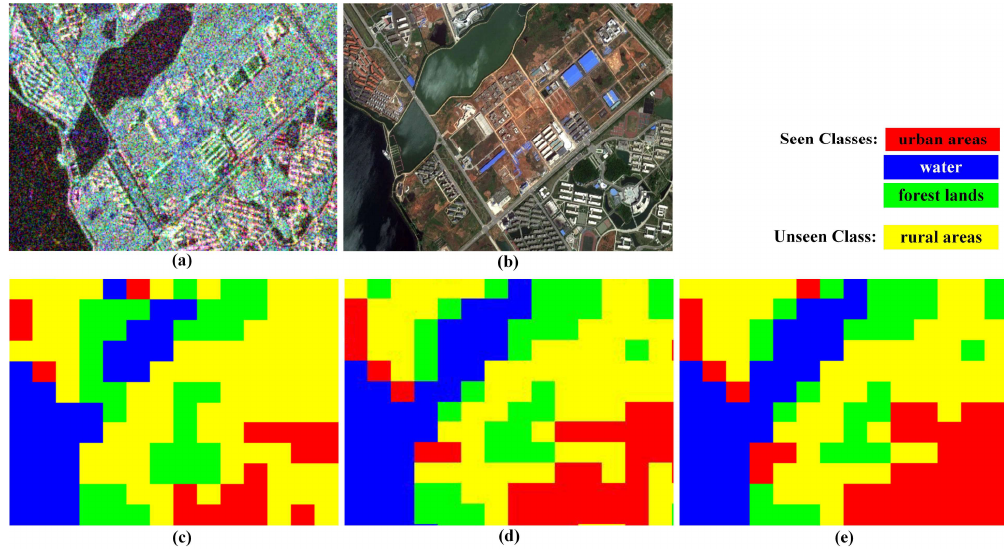
Figure 7. The ROI in Figure 6 and the GZSL classification results. ( a ) The Pauli image of ROI; ( b ) the corresponding Google Earth optical image of ROI; ( c ) the results with the Word2Vec attributes applied; ( d ) the results with the SUN attributes applied; and ( e ) the results with the selected SUN attributes applied.